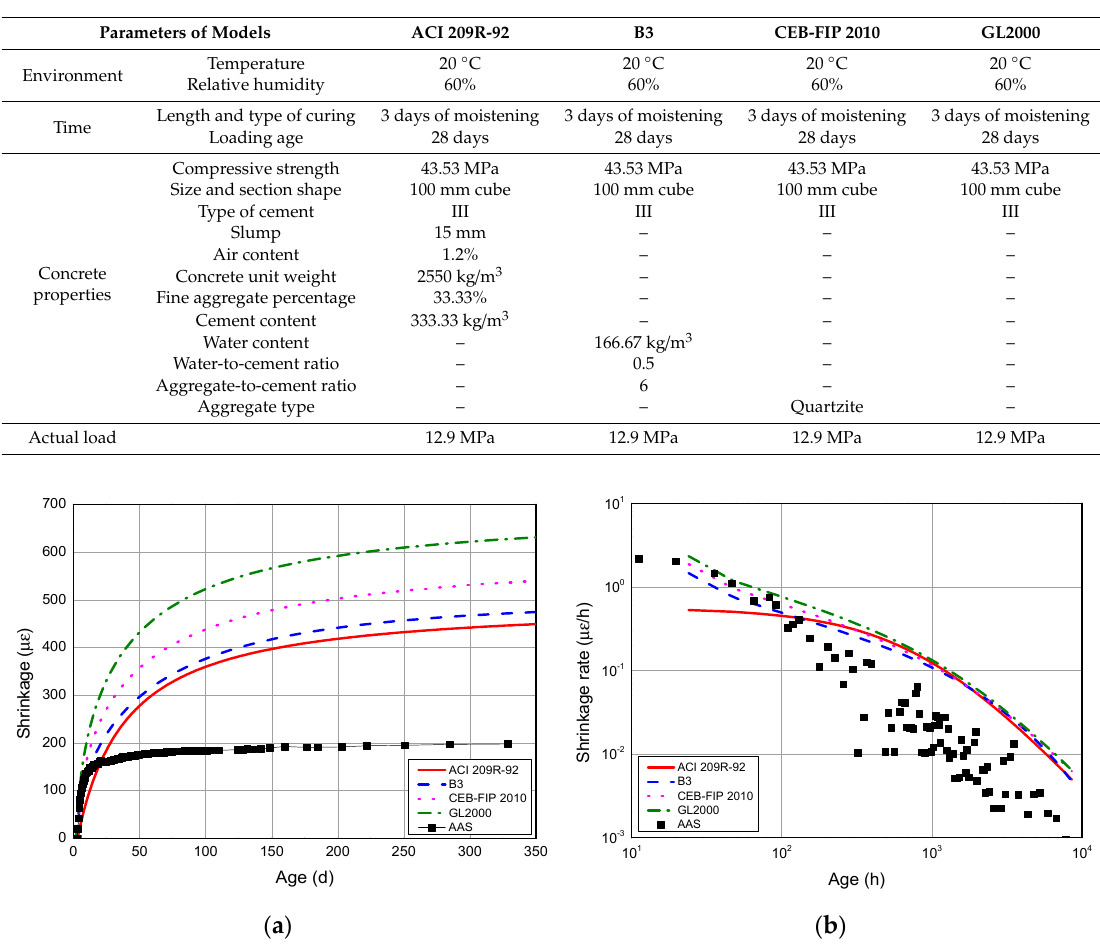
Figure 7. Drying shrinkage and model-predicted drying shrinkage of AAS concrete beginning from day 3. ( a ) shrinkage strain; ( b ) shrinkage rate.